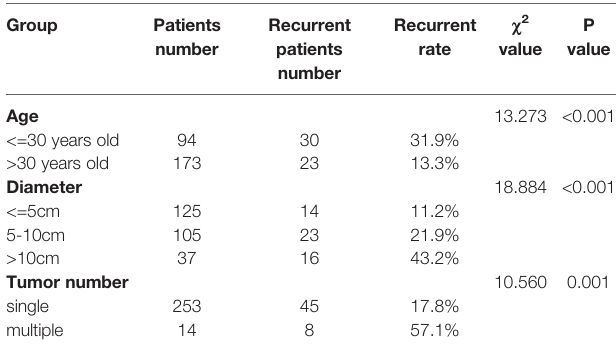
TABLE 2 | Comparison of recurrence rate in terms of three variables: age, diameter and tumor number.